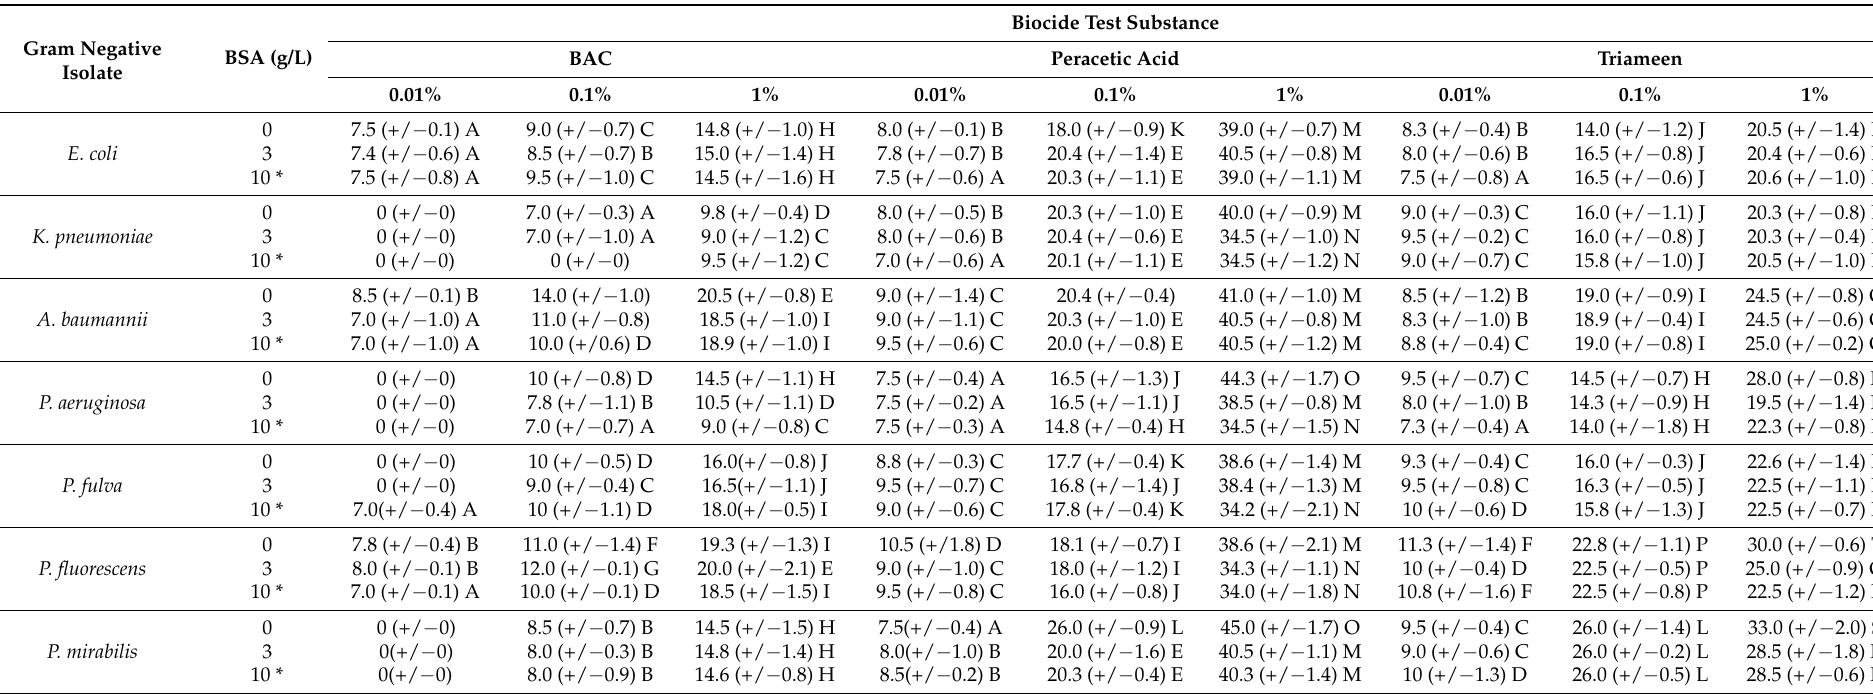
Table 4. Zones of inhibition (mm) produced by antimicrobial biocides against Gram-negative MDR isolates in the absence and presence of interfering substance BSA at 3 and 10 g/L (+10 g/L YE) (+/ − Standard